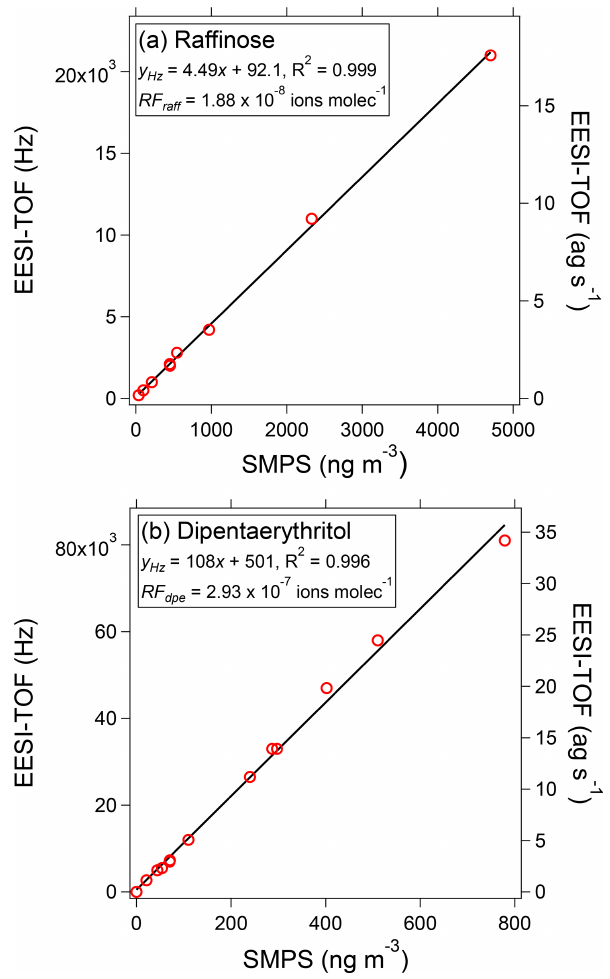
Figure 3. EESI-TOF signal as a function of mass concentration measured by a scanning mobility particle sizer (SMPS), assuming spherical particles with the material density of the pure compound, for raffinose (a) and dipentaerythritol (b) . The EESI-TOF signal is represented both in terms of the flux of ions (left axis) and mass (right axis) reaching the